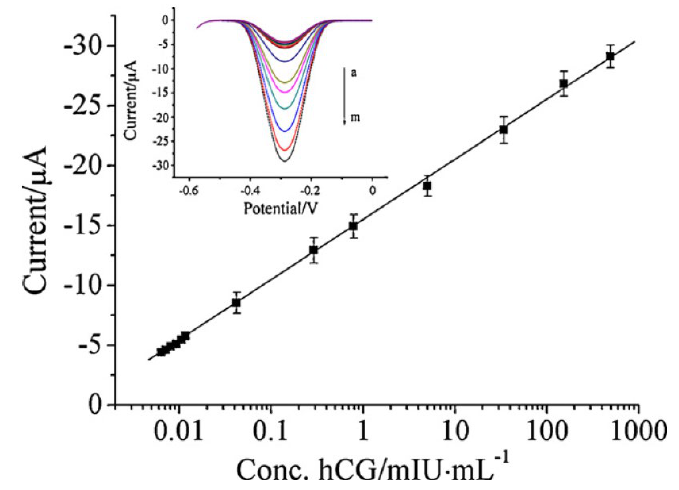
Figure 5. Calibration curves of the electrochemical immunosensor toward hCG standards in pH 7.0 PBS containing 2 mmol L −1 H 2 O 2 . Reprinted from Ultrasensitive electrochemical immunosensor based on